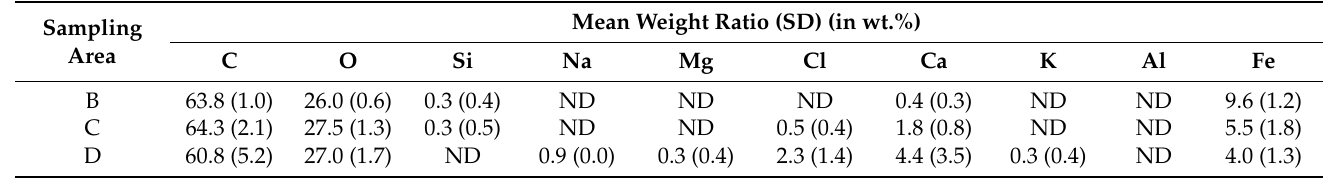
Mean Weight Ratio (SD) (in